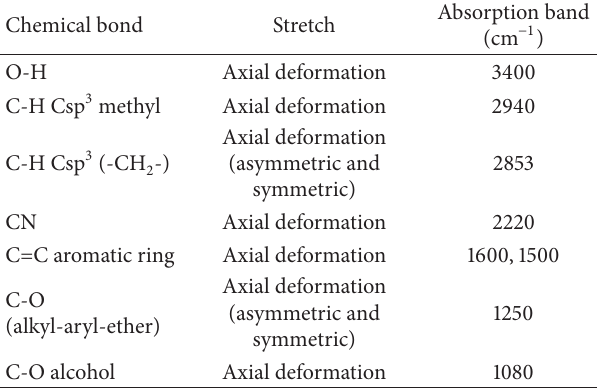
Table 3: Major bands found in the spectrum FTIR of 4-[(6-hydrox- yhexyl)oxy]-2,5-dimethylbenzonitrile.